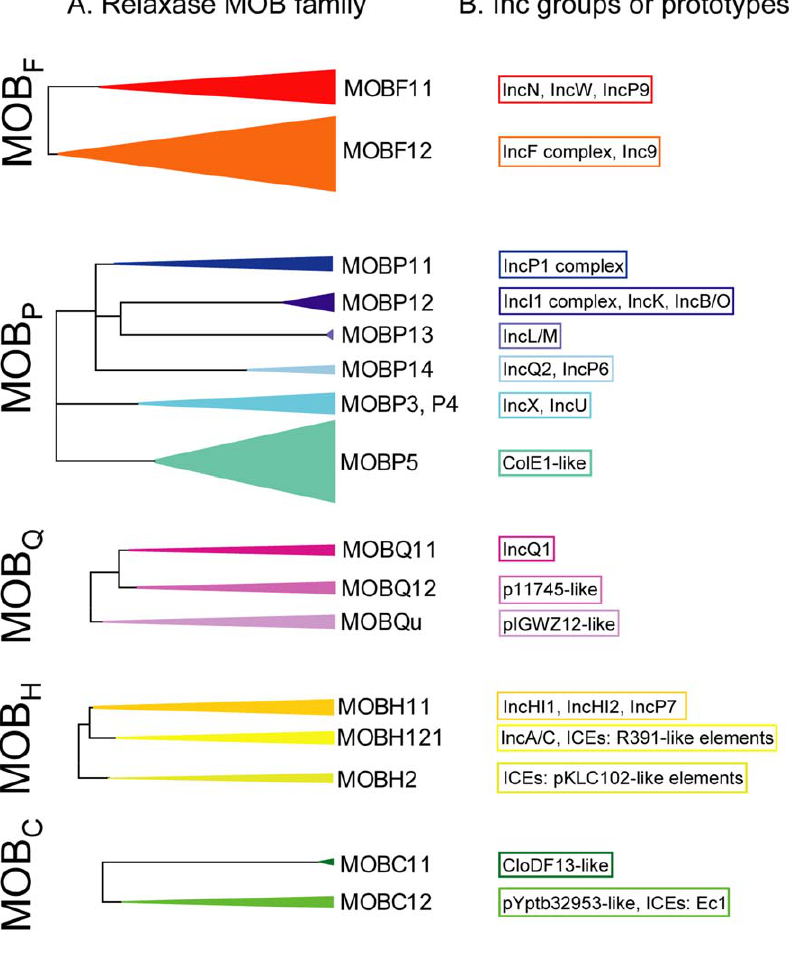
Figure 8. Correspondence between MOB and Rep types. A) Simplified phylogenetic representation of the five relaxase MOB families considered in this study. Coloured triangles represent the MOB subfamilies amplified by DPTM. Their width and depth correspond, respectively, to the abundance and phylogenetic diversity of their relaxase sequences (Table S1). B) The Inc groups contained within each MOB subfamily are indicated at the right, boxed in the same colour. When no Inc group is contained, the name of a prototype plasmid is given.